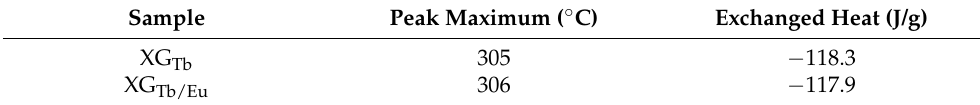
Table 2. The parameters from DCS curves recorded for fabricated silicate sol–gel